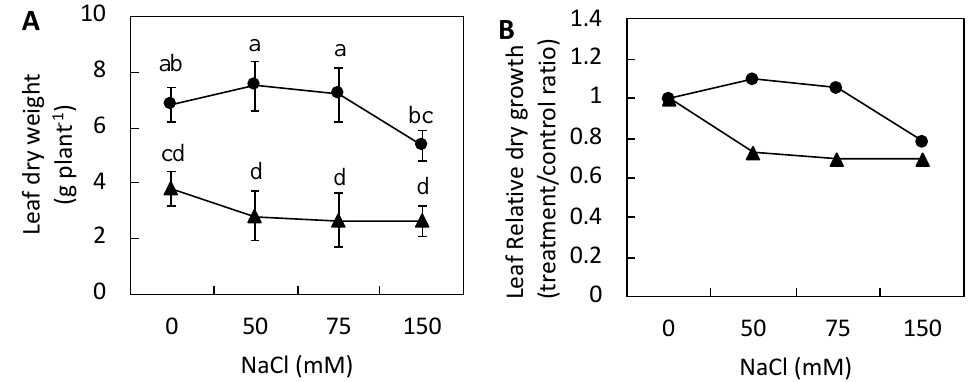
Figure 2. The effects of increasing NaCl stress on the dry weights of barley ( ) and Peucedanum japonicum (•). ( A ) Dry leaf weight and ( B ) dry leaf relative growth at each NaCl concentration compared with that of the control (0 mM NaCl). The values represent the means (±SE) of four replicates. Different letters in the figures indicate significant differences between the treatments of both plant species at P ≤ 0.05, as determined using a one-way ANOVA with the Duncan test (5% significance level).